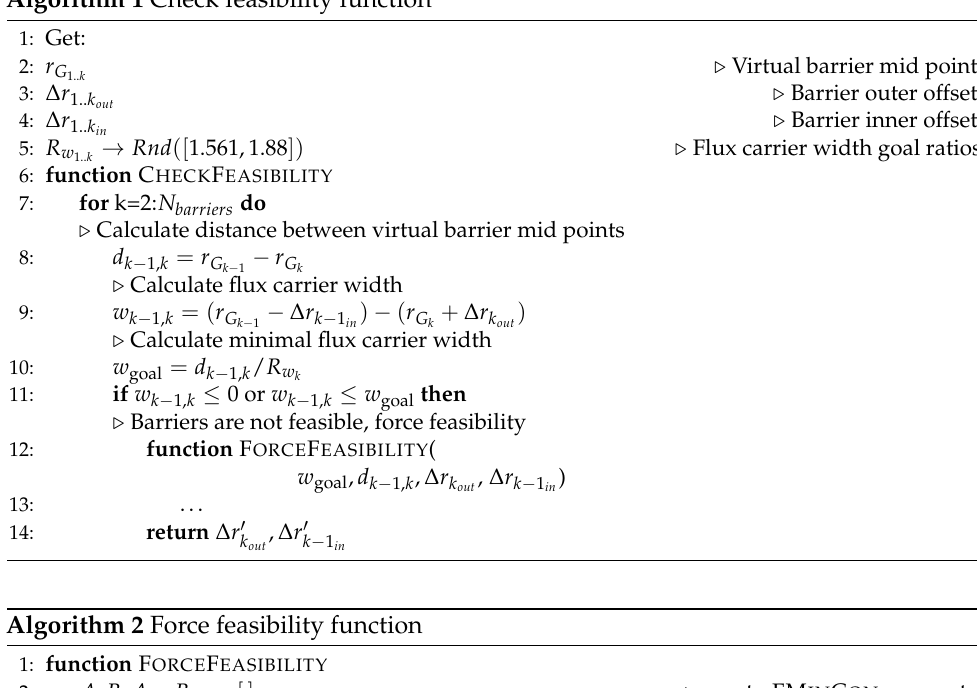
Algorithm 1 Check feasibility function